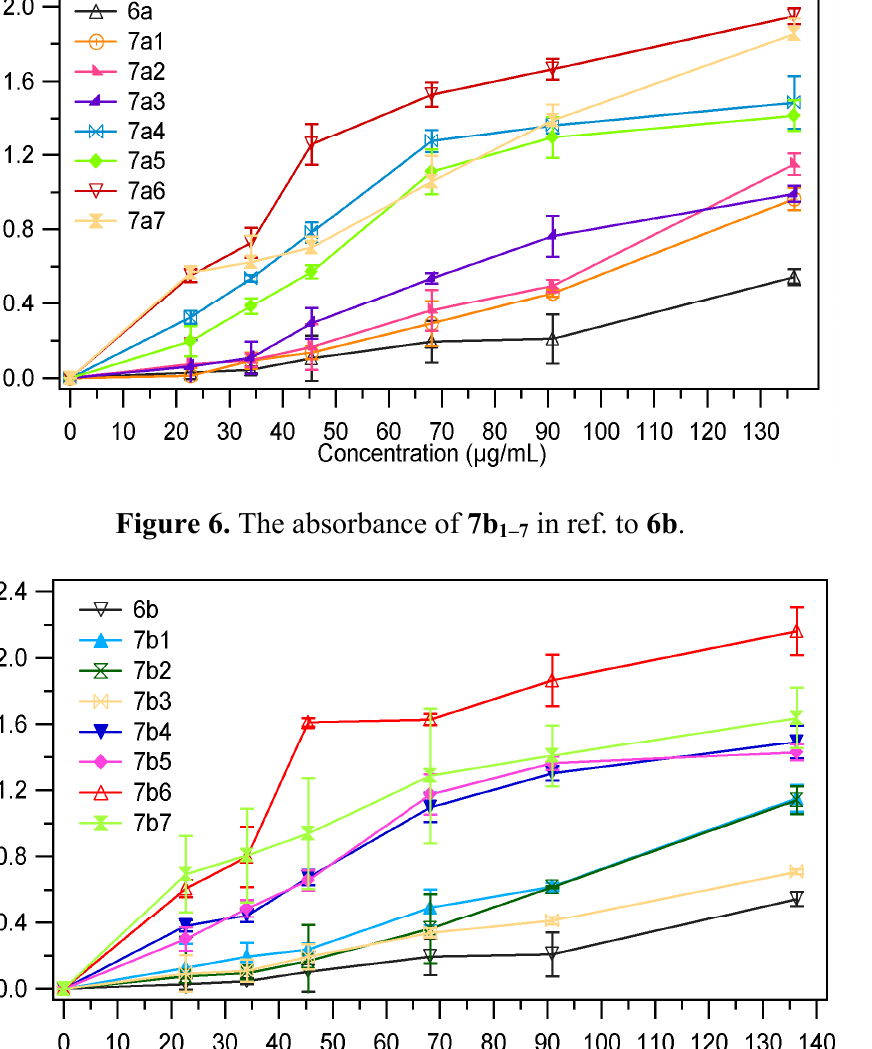
Figure 5. The absorbance of 7a